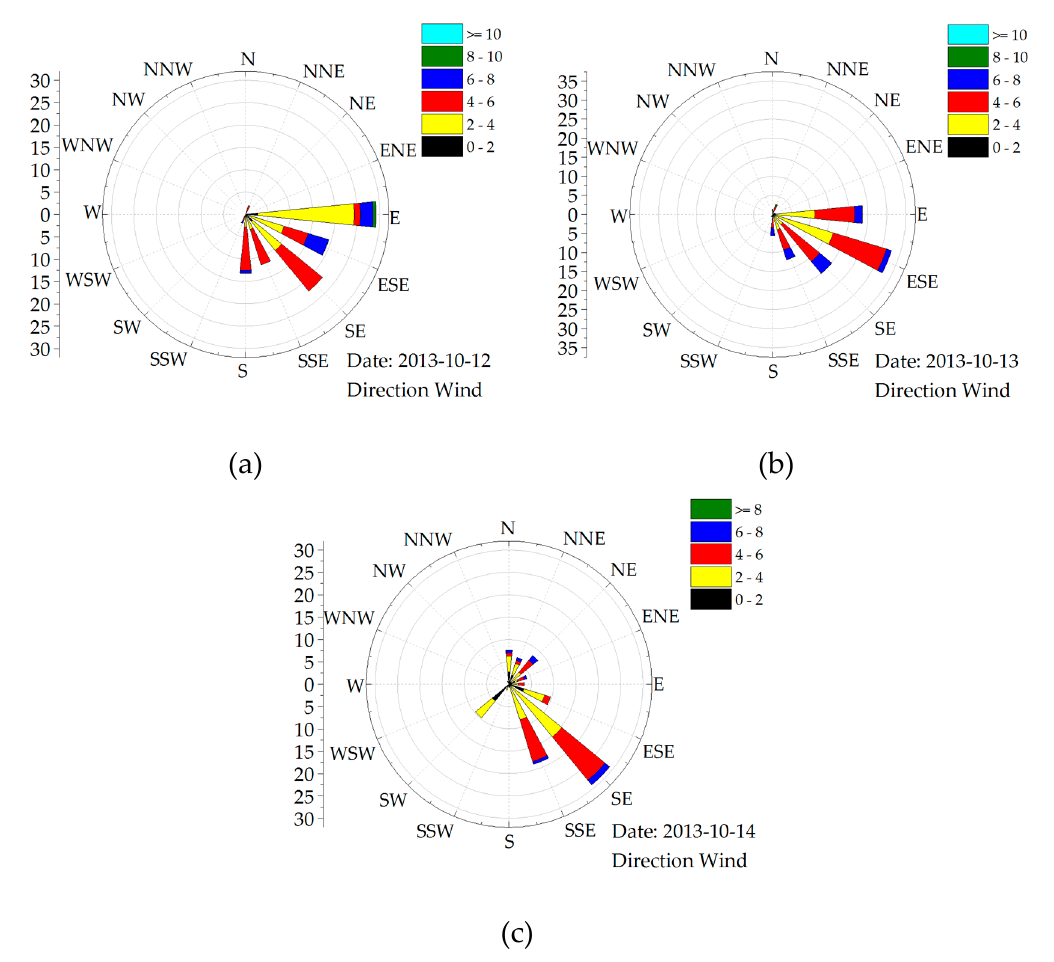
Figure 11. Images of the wind speed and direction from 12–14 October 2013 ( a–c